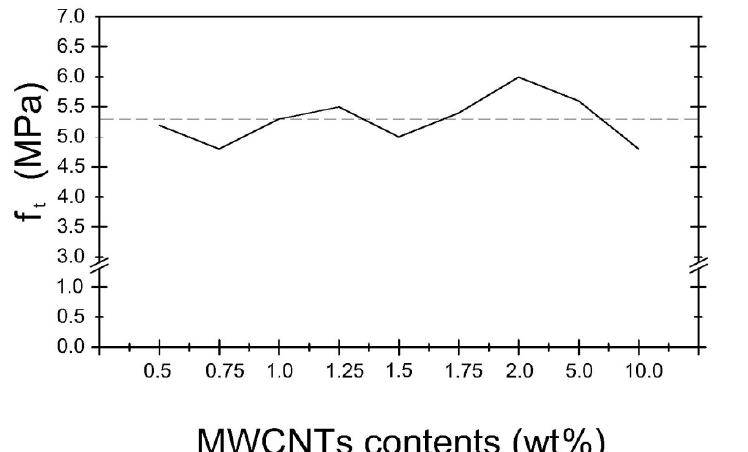
Figure 6: Indirect tensile strength (from “brazilian” tests) in function of CNTs content after 7 days of curing (dashed line represents mechanical strength of samples without carbon nanotubes).